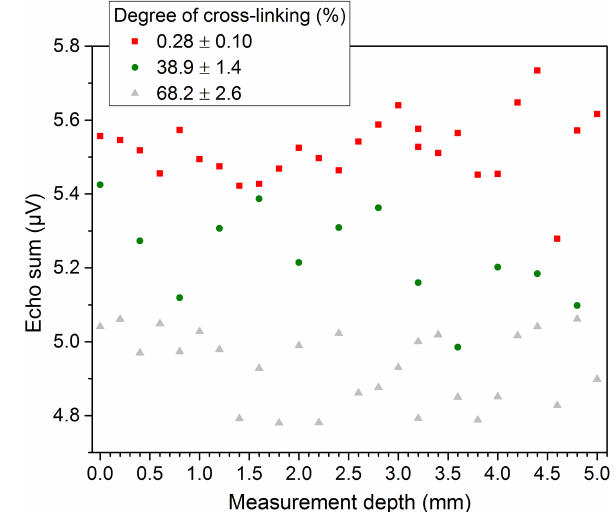
Figure 13. Ion viscosity of the DEA measurement of the 2C adhe- sive (DELO-DUOPOX AD840) at 80 ◦